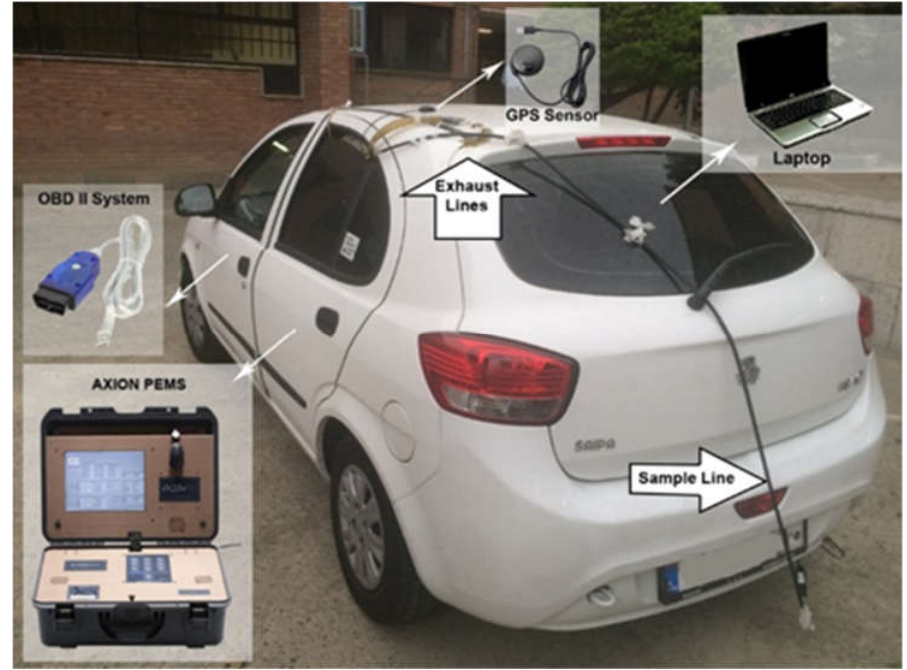
Figure 1. Installation of the PEMS’ main components on the test vehicle.